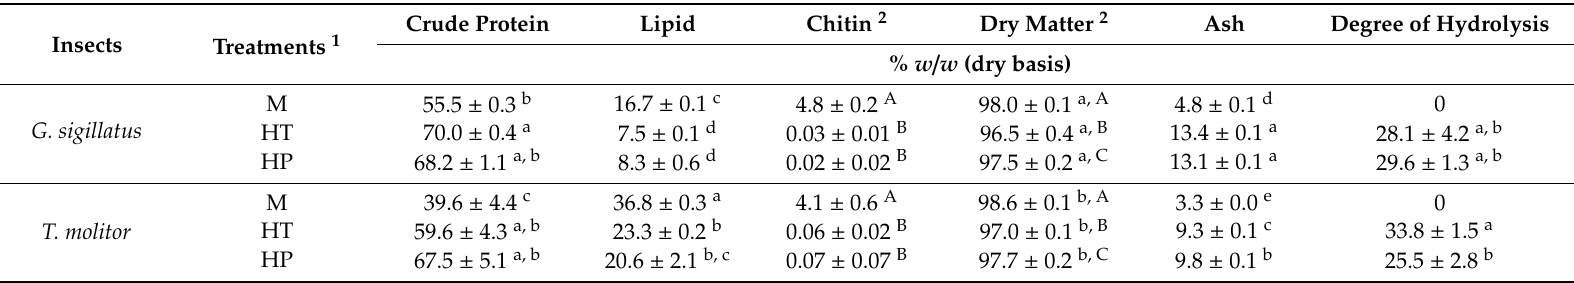
Table 1. Proximate composition and degree of hydrolysis of cricket and mealworm meals and hydrolysates generated at atmospheric pressure or with the pretreatment of insect meals with high hydrostatic pressures (HHP) prior to enzymatic